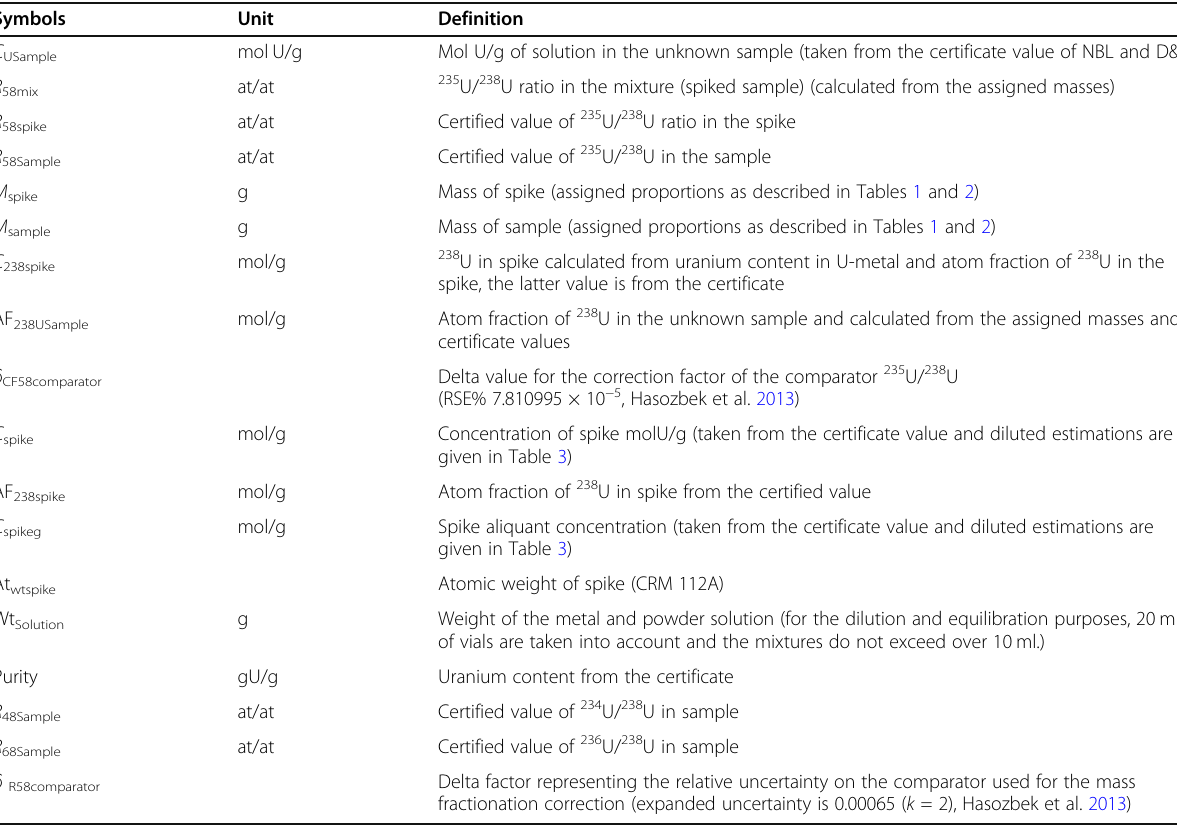
Table 6 Quantity descriptions of the model equation for the GUM workbench. Equation is taken from Bièvre De and Peiser (1997) Symbols